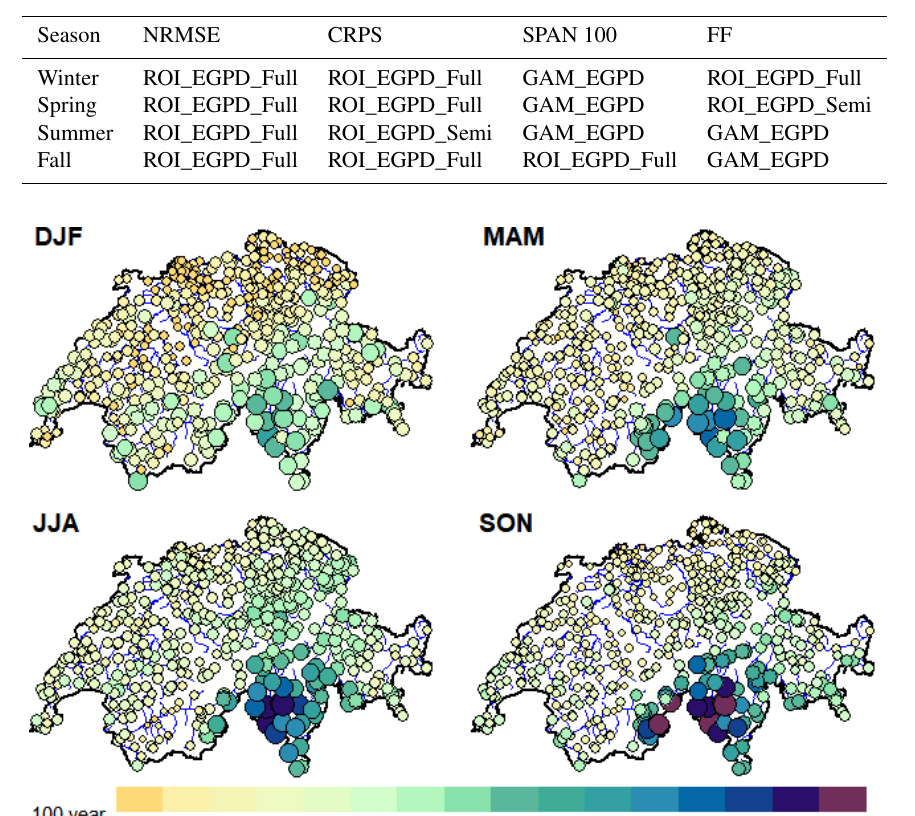
is based on the accuracy, robustness, and reliability of the models in a cross-validation framework. More precisely, we assessed the performance in both the bulk of the distribution (NRMSE and CRPS) and the upper tail (SPAN and